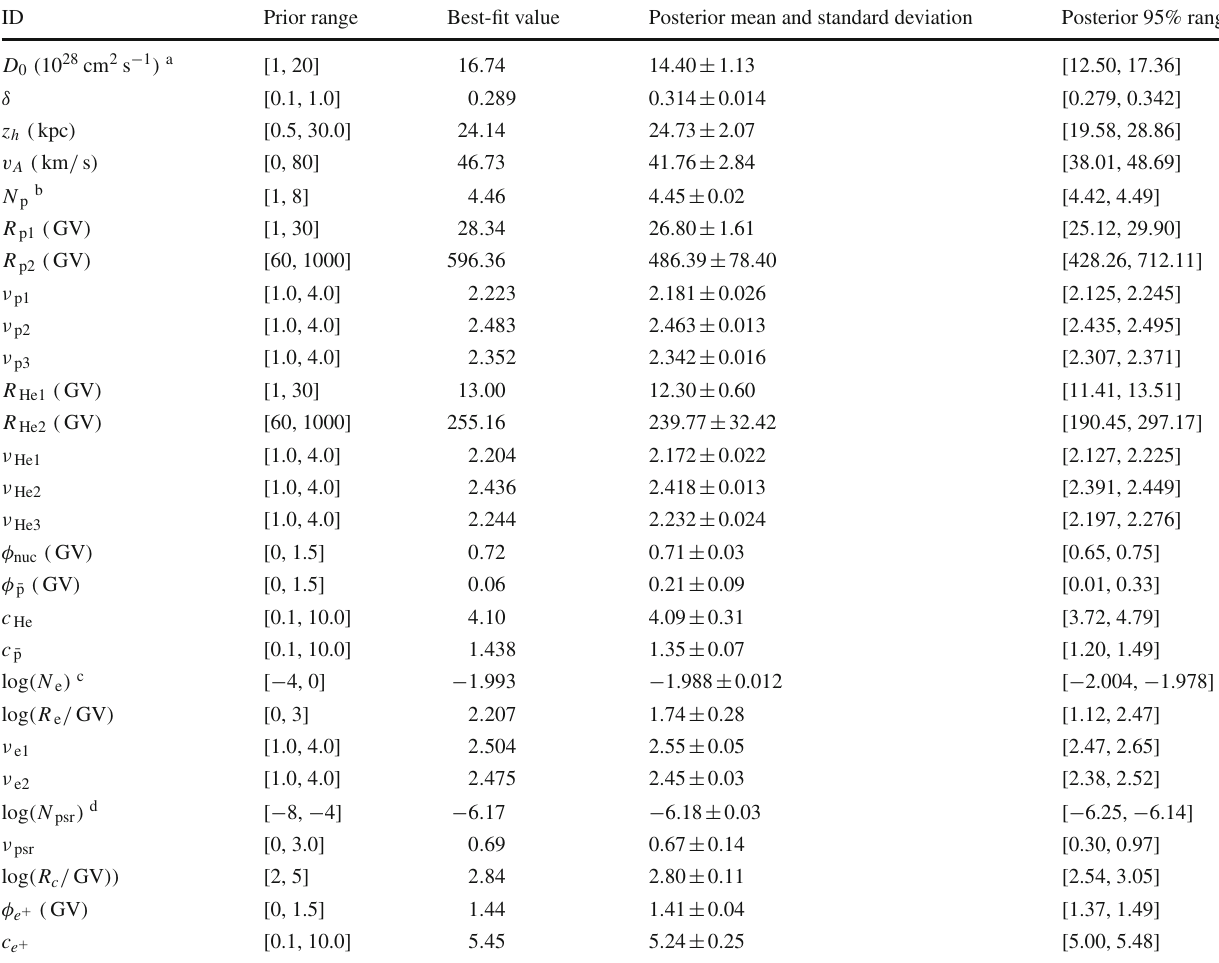
Table3 ConstraintsontheparametersofCALETCREspectrum,pulsarscenario.Thepriorinterval,best-fitvalue,statisticmean,standarddeviation and the allowed range at 95% CL are listed for the parameters. For the best-fit values, we have χ 2 / d . o . f . = 229 . 98 / 301